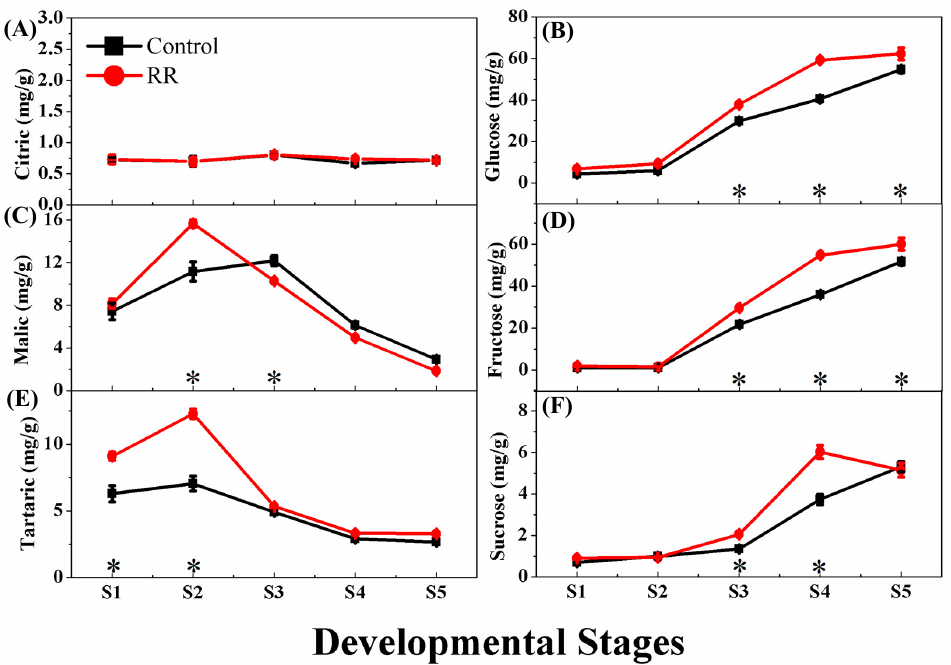
Figure 1. Effects of RR treatment on the content change of sugars and organic acids of the grape berry. ( A ) Citric; ( B ) glucose; ( C ) malic; ( D ) fructose; ( E ) tartaric; ( F ) sucrose. * indicates significant differences ( p < 0.05, n = 3).